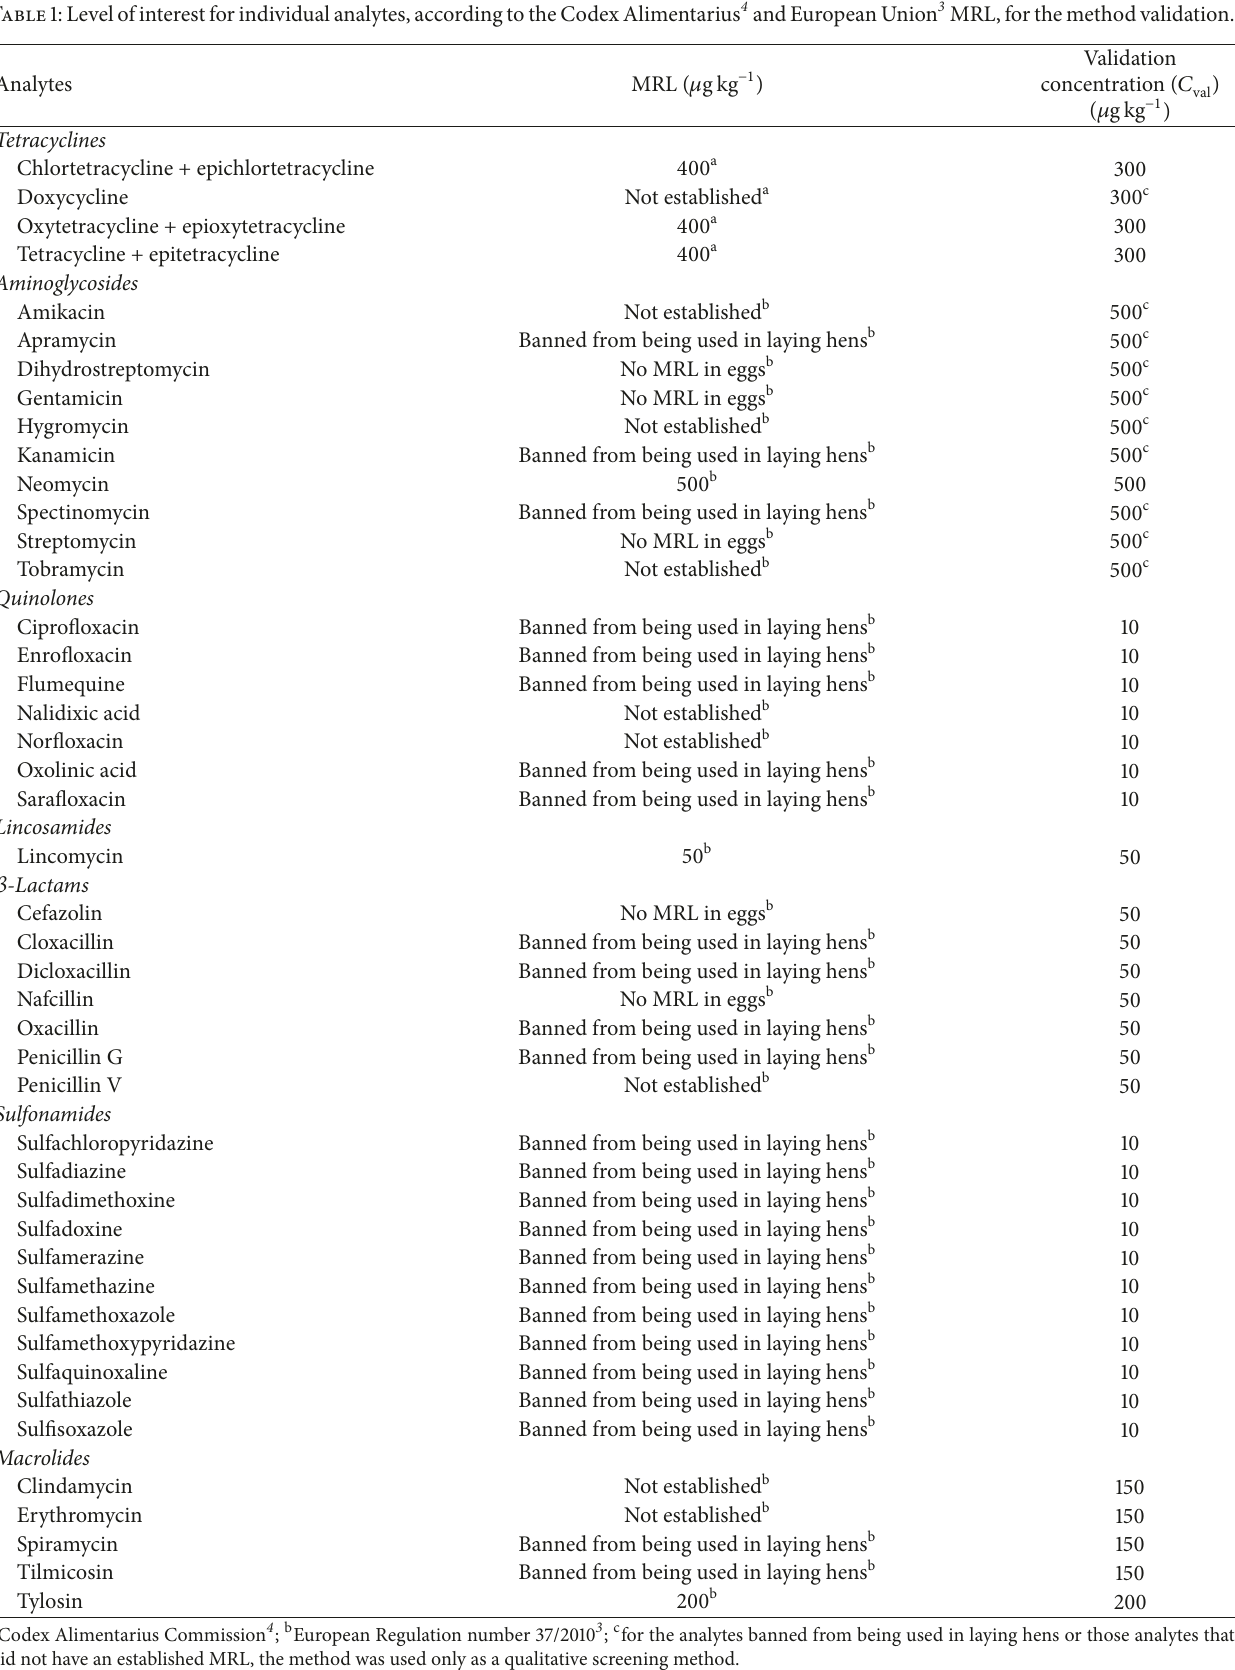
Table1:Levelofinterestforindividualanalytes,accordingtotheCodexAlimentarius 4 andEuropeanUnion 3